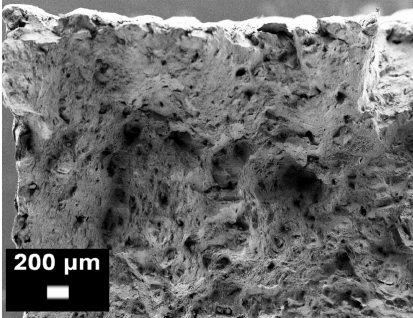
Figure 14. Example of an SLM AlSi10Mg fracture surface after a tensile test observed by FESEM. The presence of significant micro-porosity on the fracture surface can easily be evinced (from the authors’ own unpublished work).